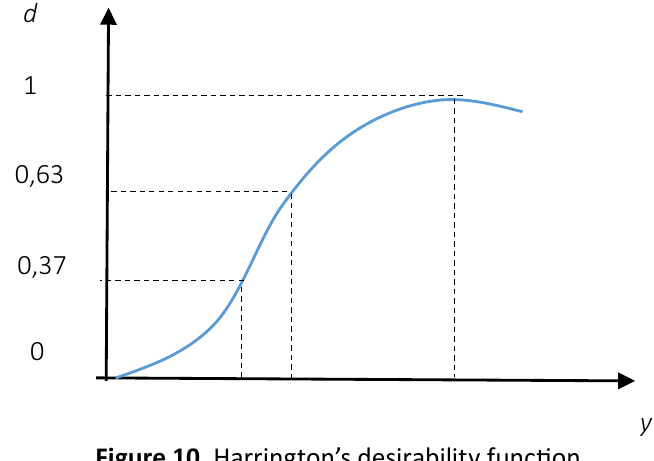
Figure 10. Harrington’s desirability